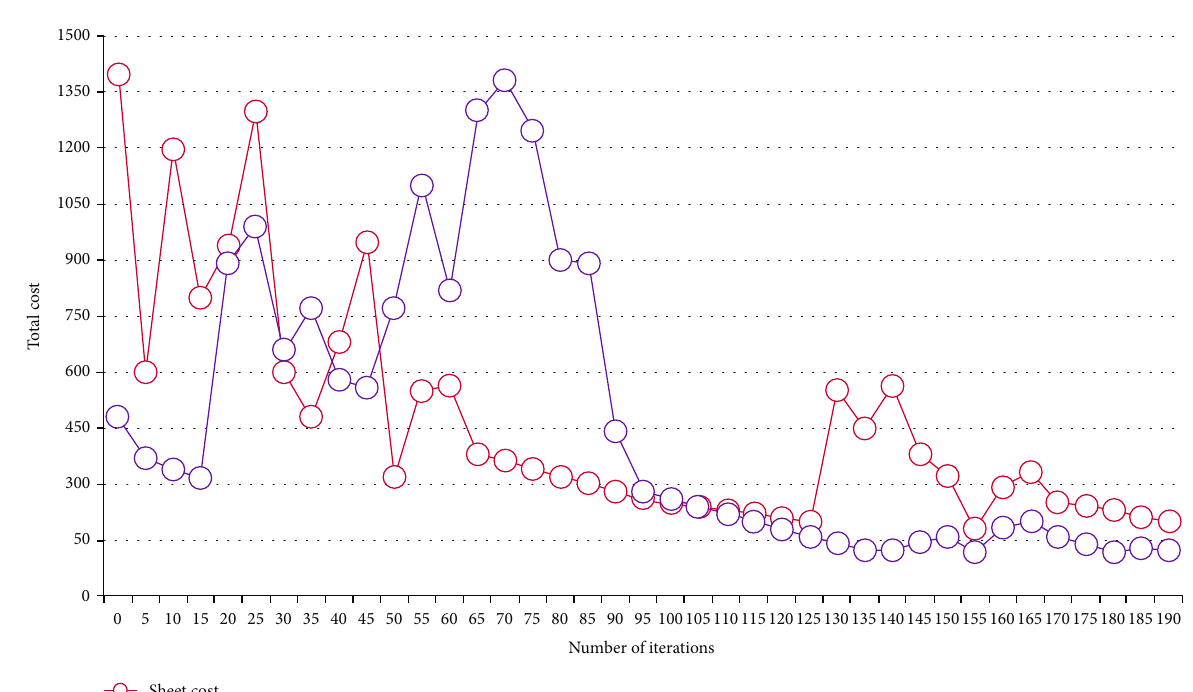
Figure 7: Total cost change curve.